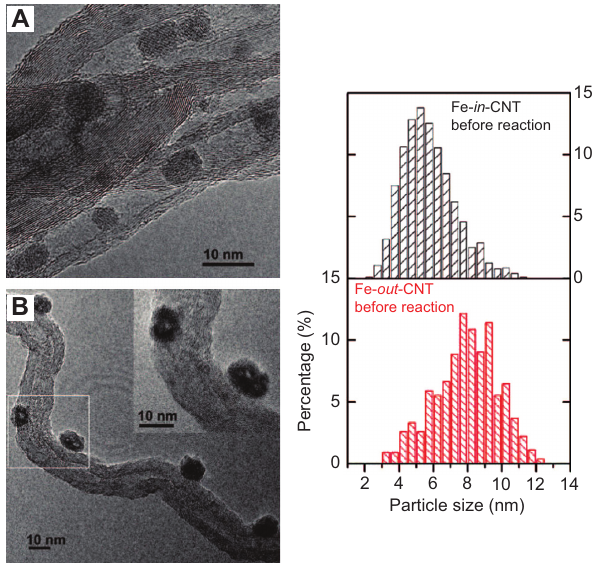
Figure 6 TEM images and particle size distribution of the activated catalysts (A) Fe-in-CNT and (B) Fe-out-CNT before reaction (Reprinted with permission from ref [133]. Copyright (2008) American Chemical Society).